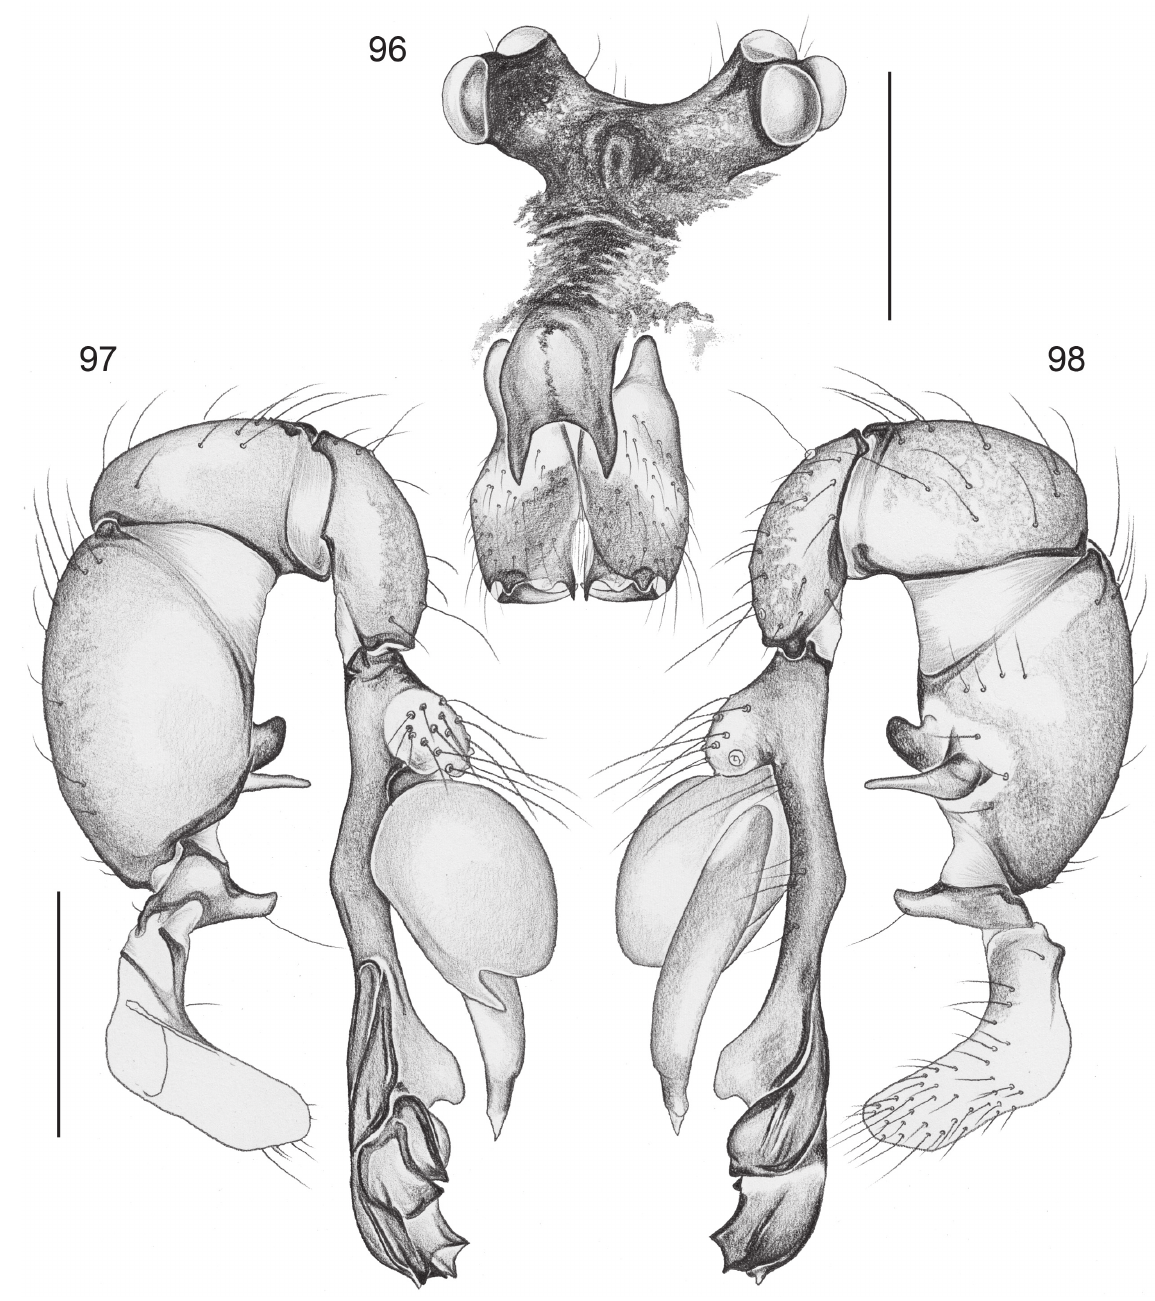
Figs 96–98. Aetana pasambai Huber, sp. nov. 96 . Male prosoma, oblique frontal view. 97–98 . Left male palp, prolateral and retrolateral views. Scale lines: 0.5